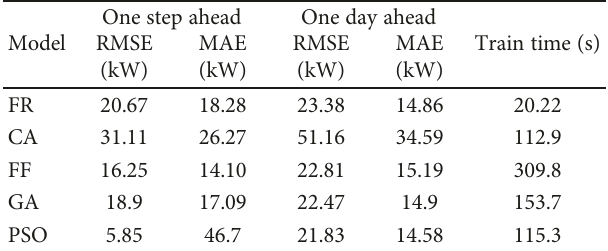
Figure 11: Fuzzy interval prediction for one day ahead (case 2) load power with coverage grades. Table 3: Comparison of prediction interval forecast for demand power.